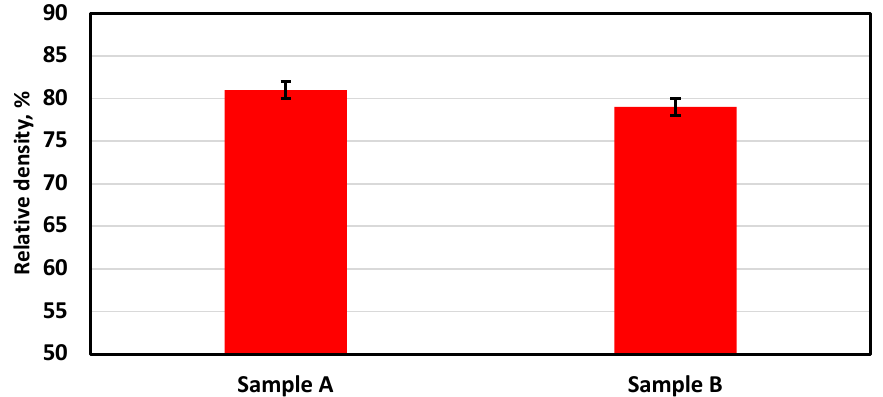
Figure 13. Relative density of alumina samples printed using the developed preheating system: with 20 W preheating laser power (Sample A) and 30 W (Sample B).